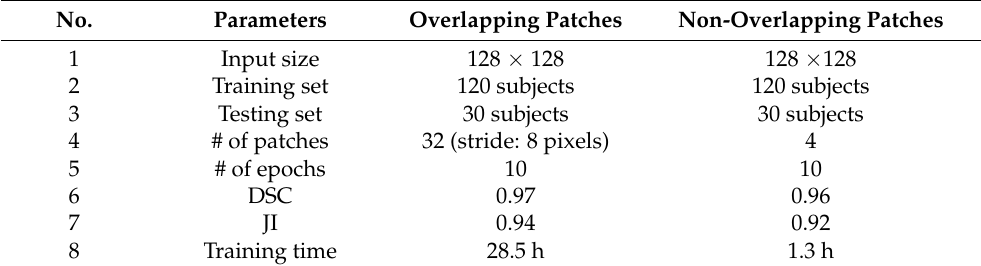
Table 5. Effects of overlapping and non-overlapping patch-wise segmentation in the proposed method.